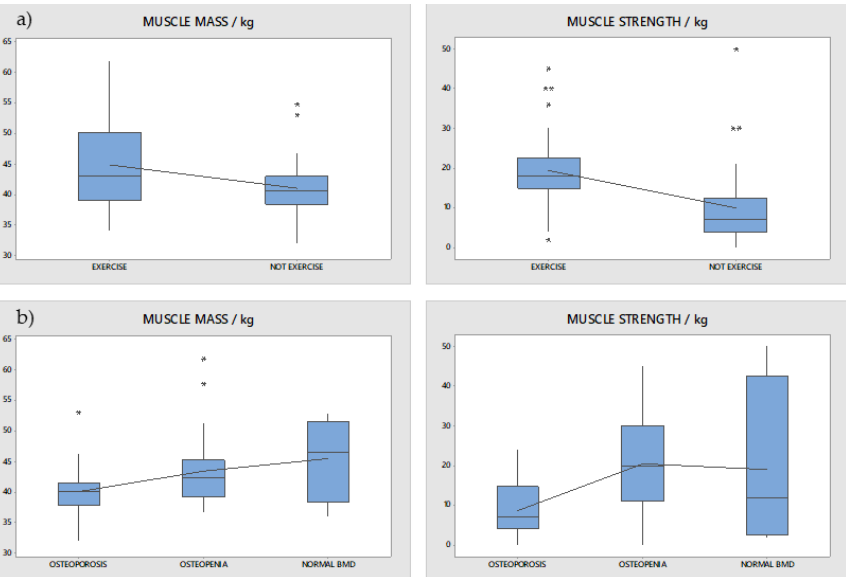
Figure 3. Differences in muscle mass and muscle strength: ( a ) between patients that performed exercises and patients that did not perform exercises ( p = 0.010); ( b ) between patients with osteoporosis, osteopenia, and normal BMD ( p = 0.000). Asterisks represent mild outliers (data points that are more extreme than Q1 − 1.5 IQR or Q3 + 1.5 IQR).